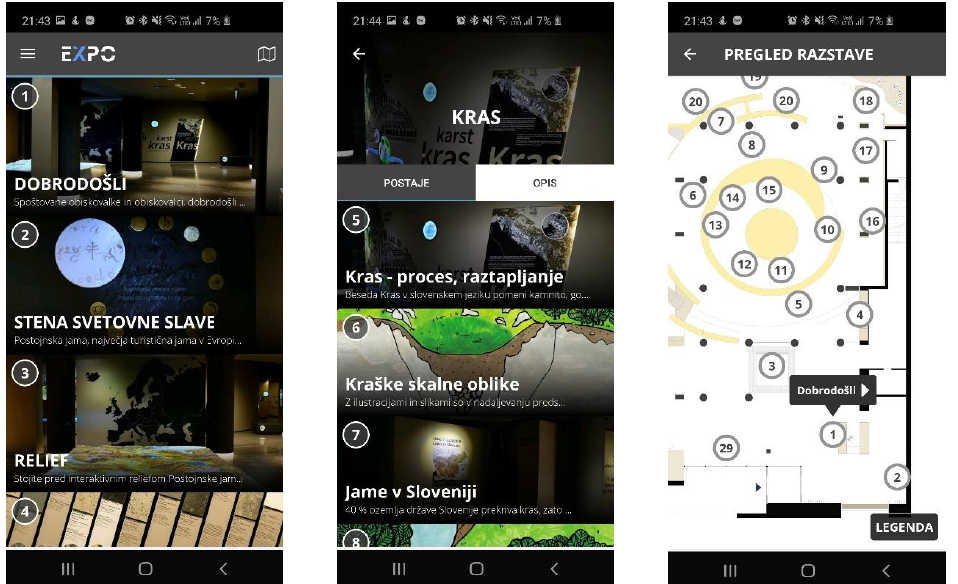
Figure 9. Screens of the Expo app for visitors (in the Slovenian language).